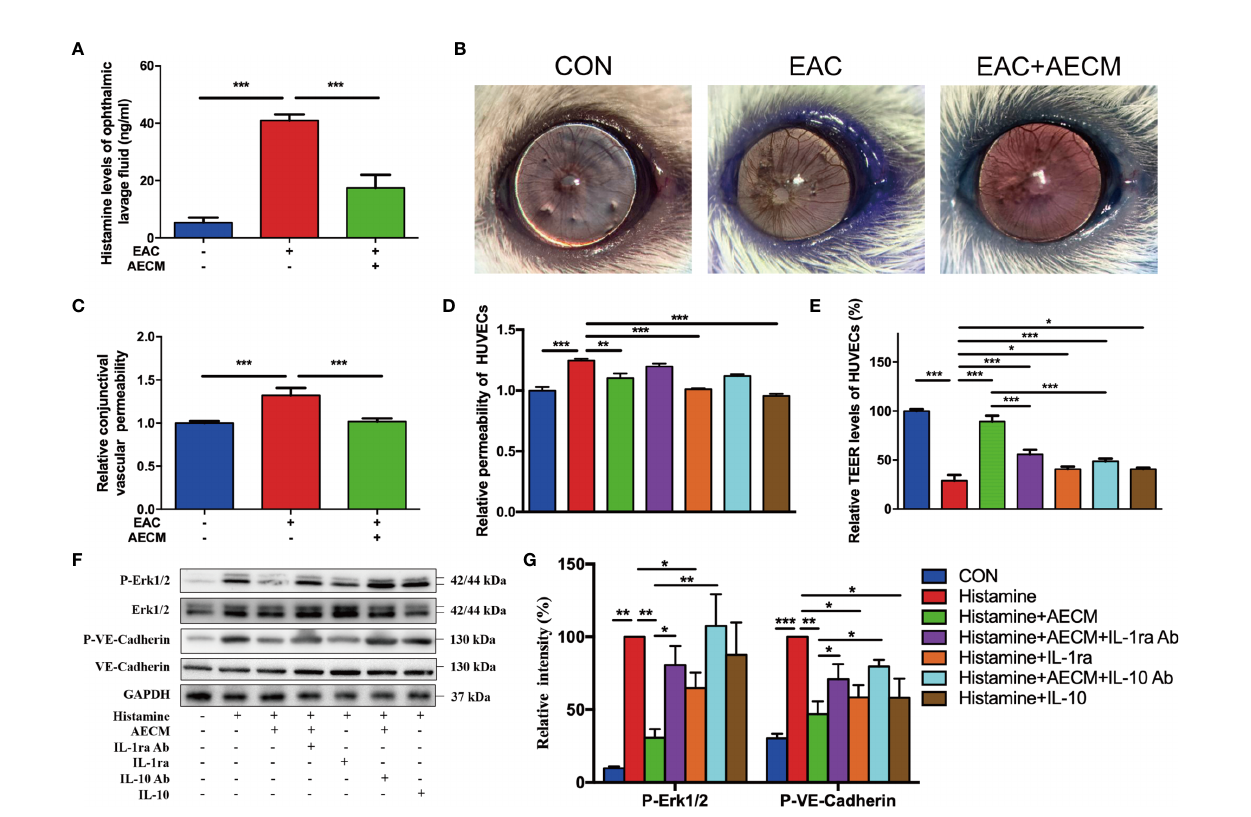
FIGURE 6 | Antihistamine effects of AECM. (A) Histamine levels in ophthalmic lavage fl uid of mice in different groups measured by ELISA. (B) Conjunctival vascular permeability of EAC mice was tested by Evans blue. Representative images were represented. (C) Quanti fi cation of conjunctival vascular permeability of EAC mice in different groups. n = 3. (D) Relative permeability of HUVECs in different treatment groups as indicated. (E) The TEER level of HUVECs in different groups. (F) Western blot analysis of protein level of p-Erk1/2 and Erk1/2, p-VE-cadherin and VE-cadherin in different treated HUVECs. The level of GAPDH was used as an internal control of the total protein of the cell lysate. (G) Quali fi cation of relative protein levels of p-Erk and p-VE-cadherin. * P < 0.05, ** P < 0.01, and *** P <